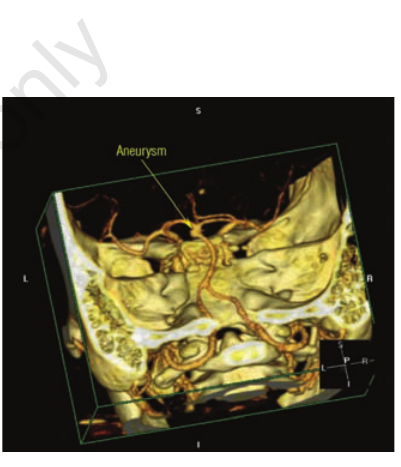
Figure 3. Computed tomography angiog- raphy showing a 4.5 mm aneurysm of the left side of the basilar artery.